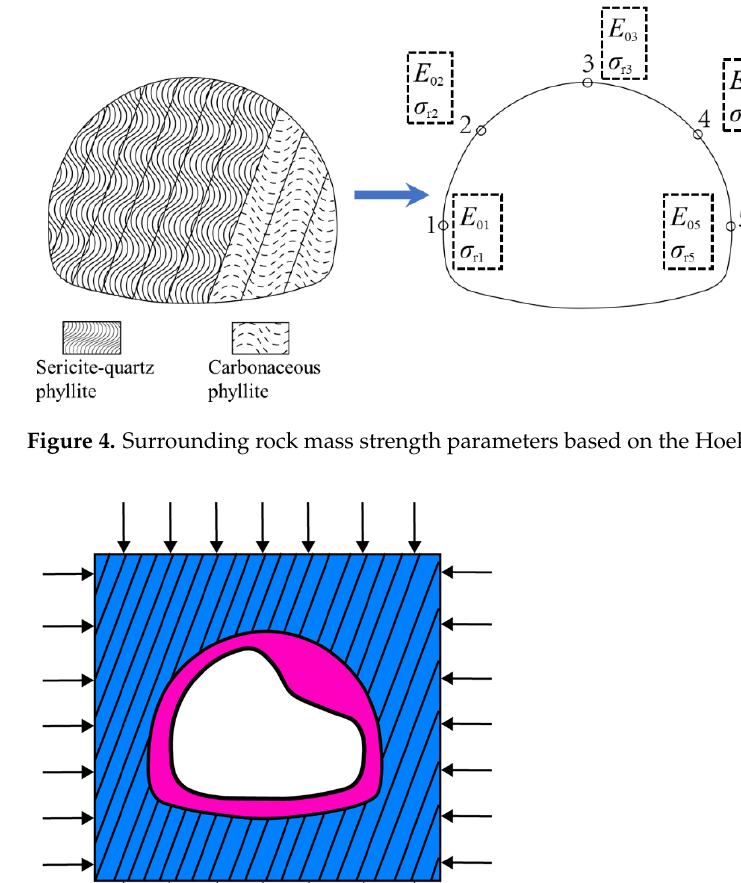
Figure 5. Schematic diagram of the surrounding rock mass deformation.